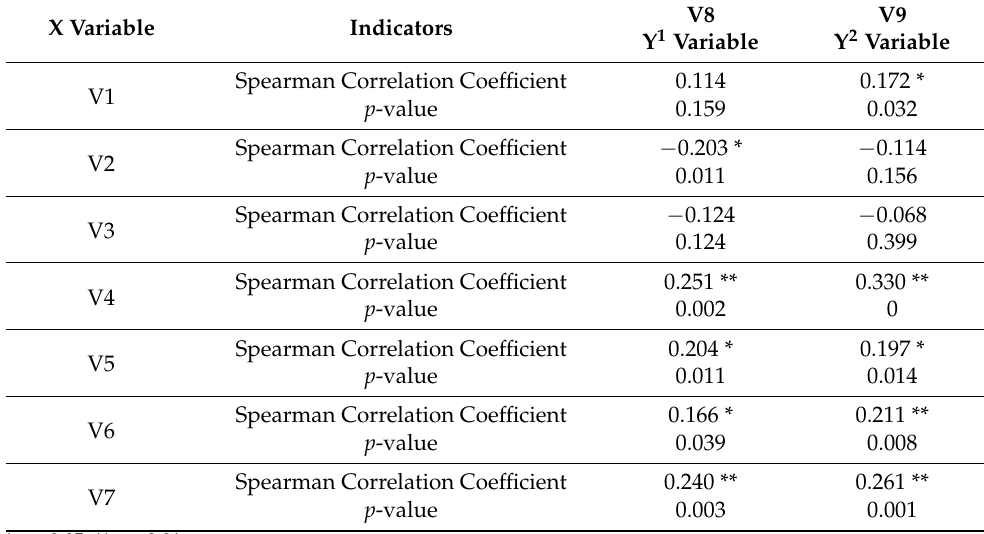
Table 9. The influencing factors of the willingness to participate and pay (made by